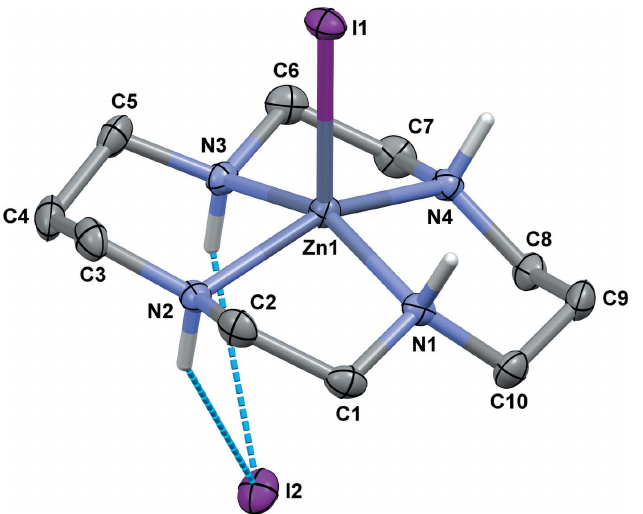
Figure 2 View of the molecular structure of II showing the atom-labeling scheme with displacement ellipsoids drawn at the 30% probability level. C-bound H atoms are omitted for clarity. Symmetry codes: (i) (cid:3) x + 3 (ii) (cid:3) x + 3 , y (cid:3) 1 , (cid:3) z + 1 ; (iii) (cid:3) x + 2, y , (cid:3) z + 1; (iv) (cid:3) x + 1, y , (cid:3) z + 2 2 2